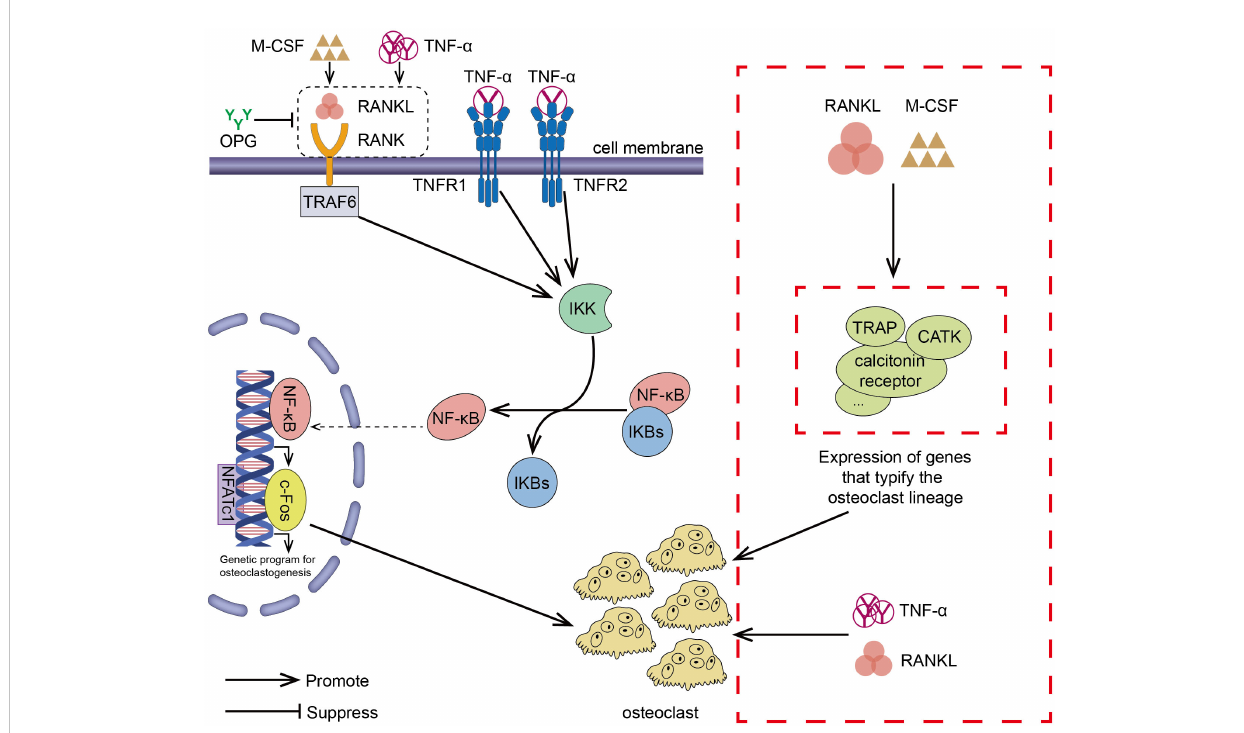
FIGURE 2 RANKL/RANK/OPG is the most important signaling pathway regulating osteoclasts formation. The interaction between RANK and RANKL (which can exacerbate this effect in the presence of M-CSF) promotes the recruitment of the TRAF family bridging proteins, one of which TRAF6 contributes to OC formation and activation of the NF- k B signaling pathway, leading to the transcription of genes involved in OC formation and OC production. OPG is a decoy receptor that binds RANKL and can block the binding and activation of RANK and RANKL, reducing OC production. TNF- a /NF- k B is an in fl ammatory signaling pathway. In the presence of TNF- a , NF- k B pathway is activated, OC production is increased, and the interaction between RANKL and RANK is enhanced, which results in activation of the downstream signaling pathways. In addition to the above-mentioned effects, TNF- a also synergizes with RANKL and directly promotes OC production. In the presence of RANKL and M-CSF, the expression of genes involved in OC formation leading to the development of mature